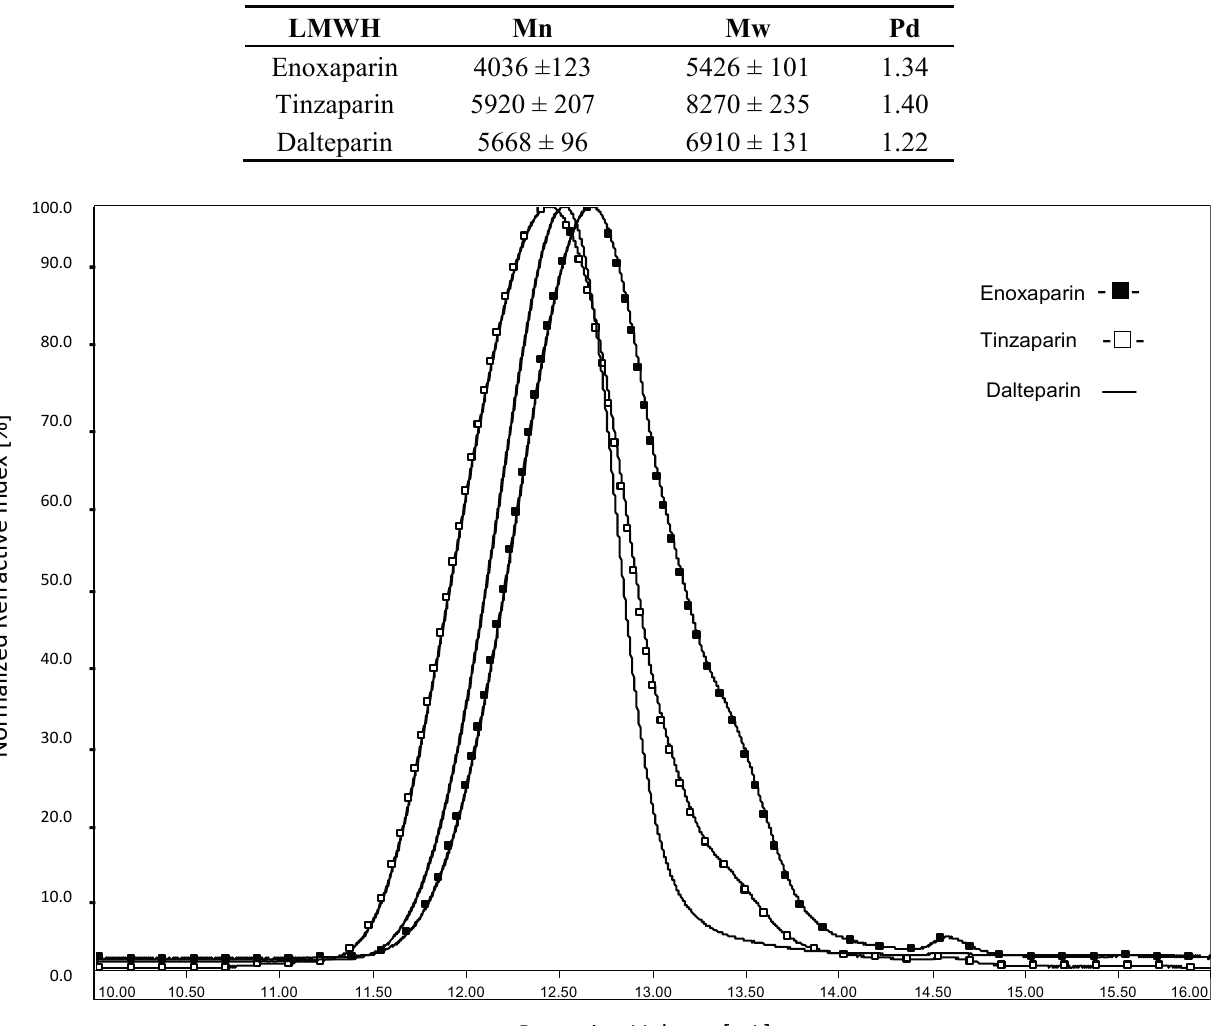
Table 3. Characterization of three LMWHs by HP-SEC/TDA method.